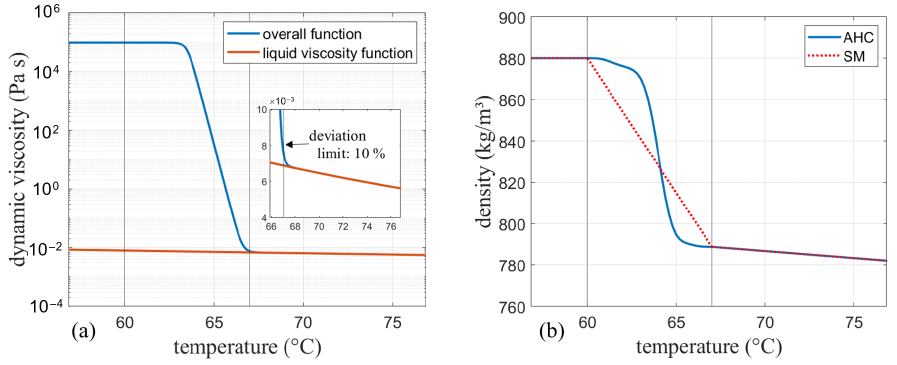
Figure 5. ( a ) Final viscosity curve for the apparent heat capacity model (AHC) and liquid viscosity for comparison. ( b ) Density curve for AHC (var. density) and the solidification and melting (SM) model.